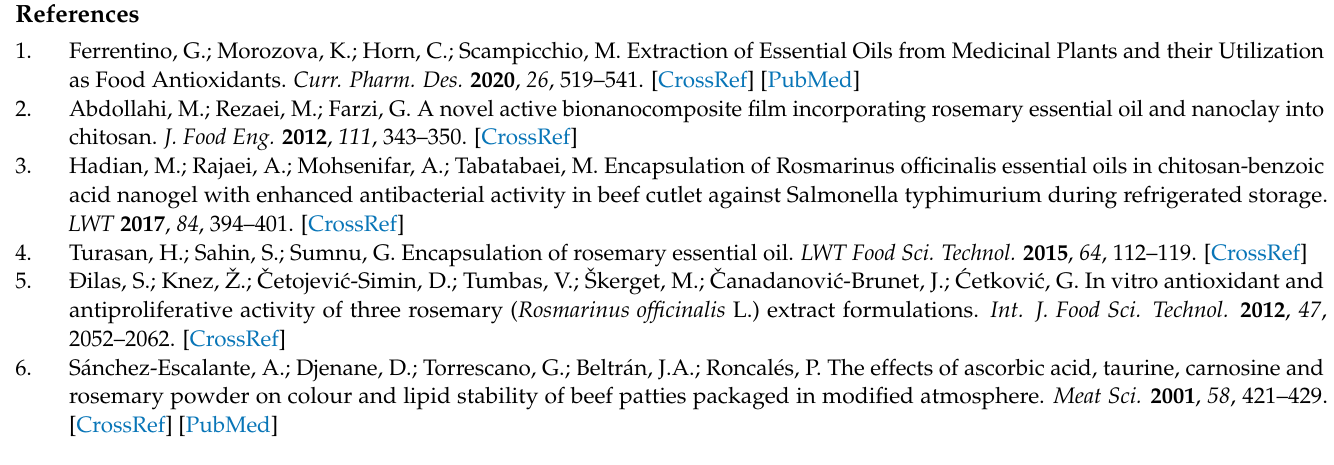
Lower case letters a,b indicate significant statistical